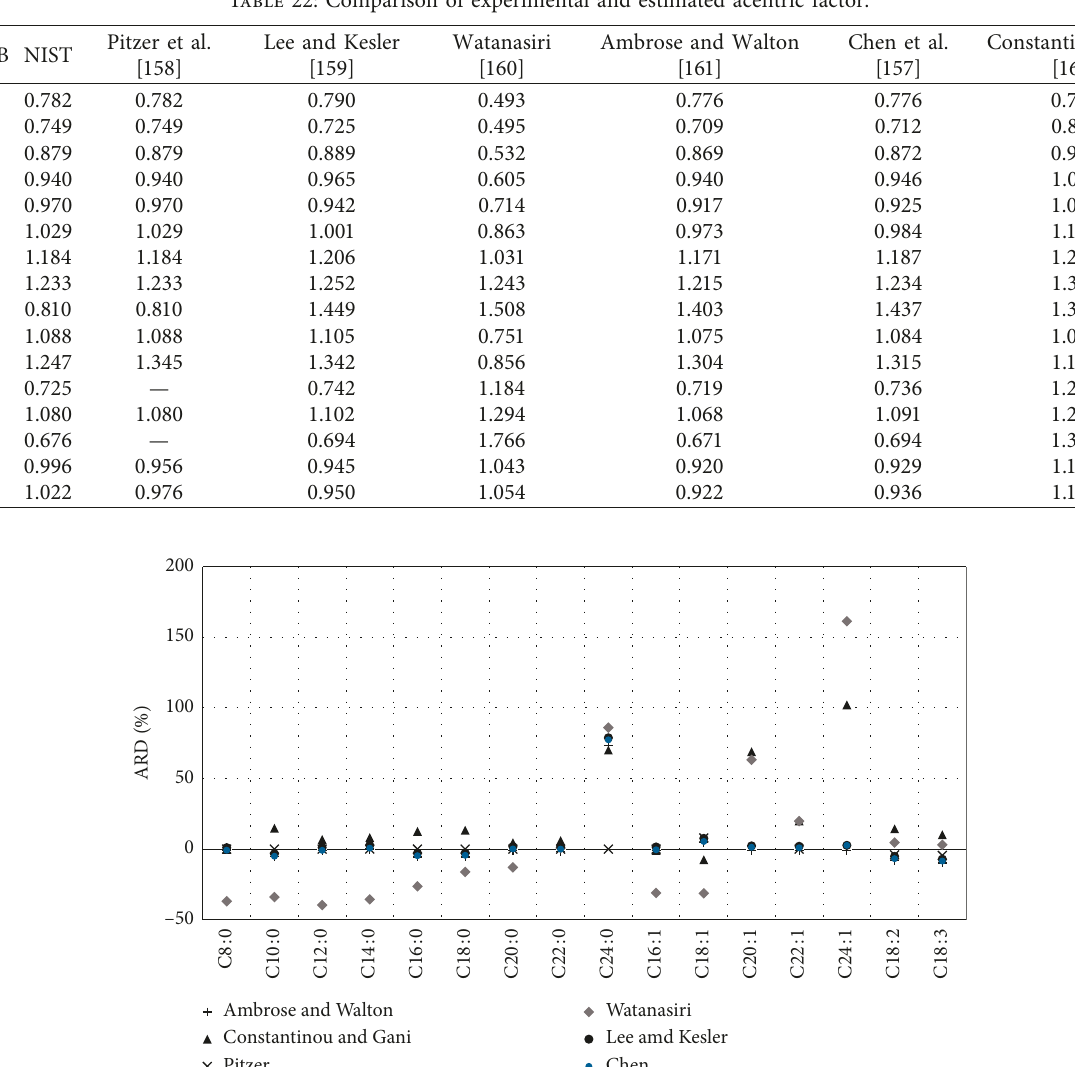
Table 22: Comparison of experimental and estimated acentric factor.